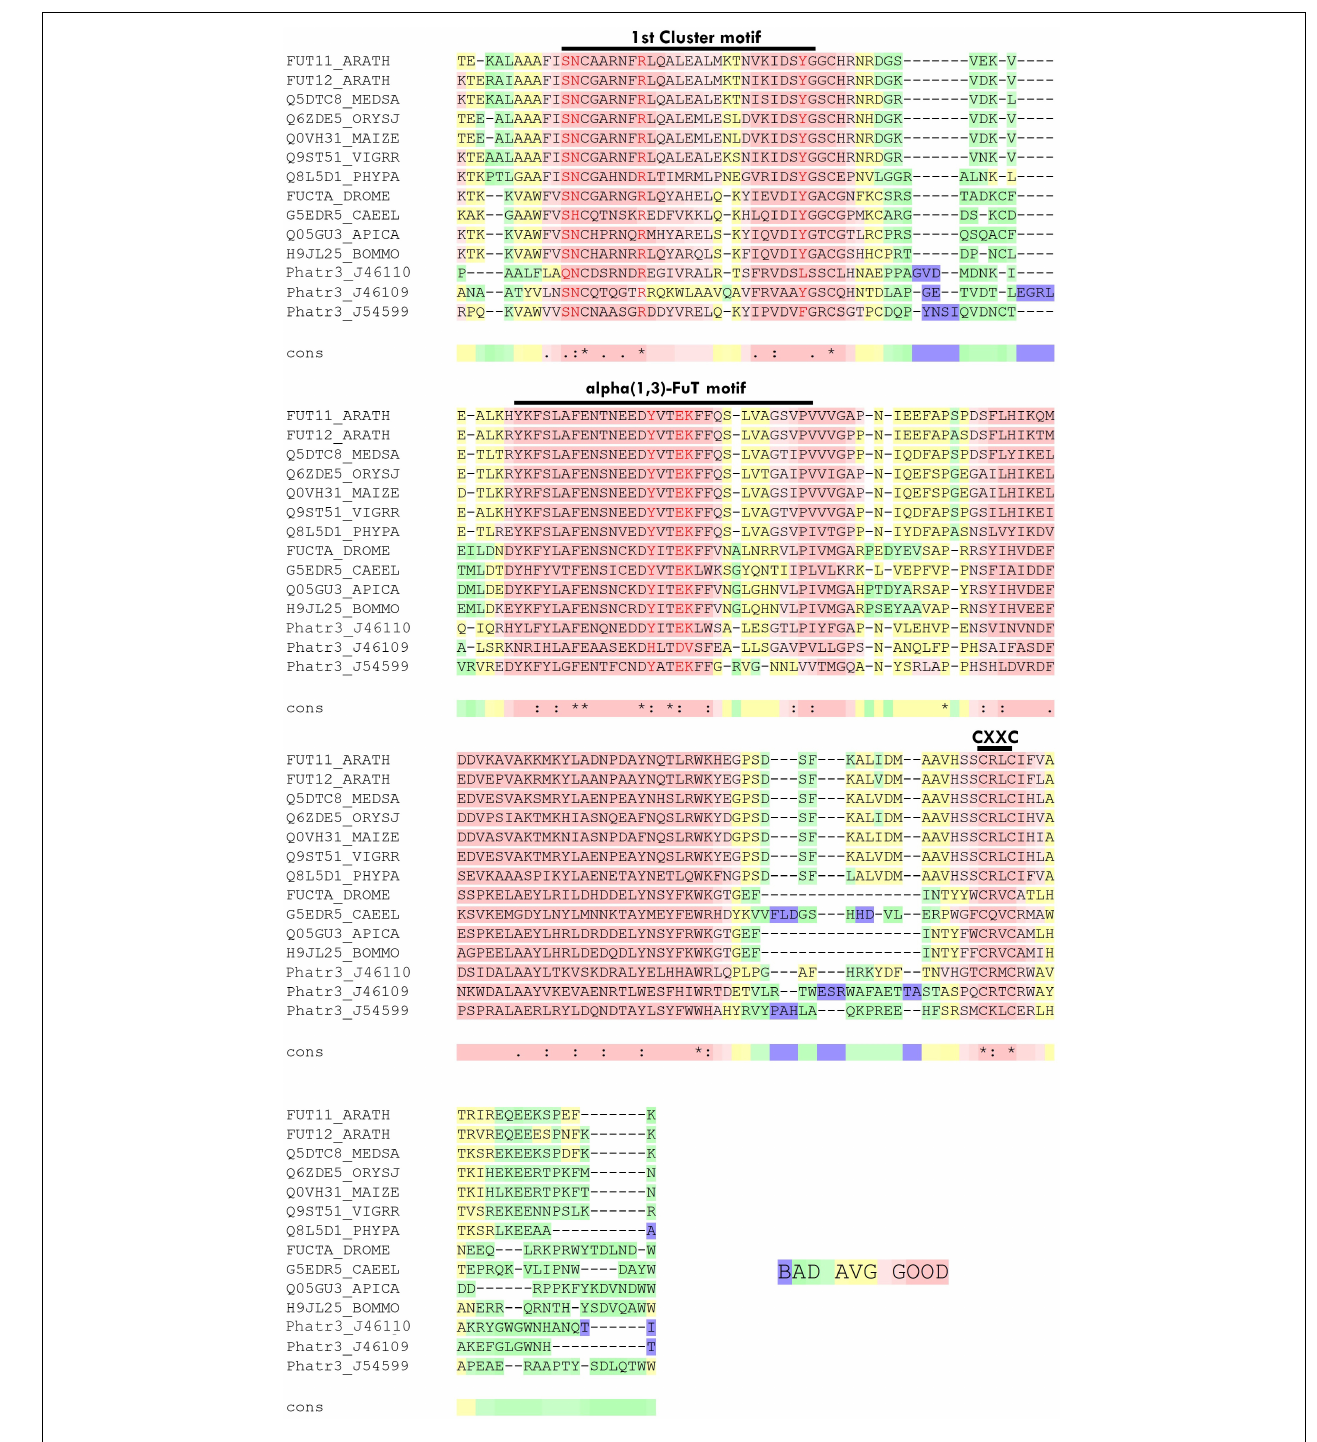
FIGURE 5 | Phaeodactylum tricornutum putative FuT exhibits strong amino acid identities with α (1,3)-fucosyltransferases. Amino acids sequences comparison with the T-coffee program (http://tcoffee.crg.cat/, Di Tommaso et al., 2011) of the C-terminal GT10 domains of the three putative fucosyltransferases encoded, respectively, by the Phatr3_J46109, Phatr3_J46110 and Phatr3_J54599 genes from Phaeodactylum tricornutum with biochemically characterized α (1,3)-fucosyltransferases from Arabidopsis thaliana (FUT11_ARATH and FUT12_ARATH), Medicago sativa (Q5DTC8_MEDSA), Oryza sativa (Q6ZDE5_ORYSJ), Zea mays Q0VH31_MAIZE), Vigna radiata (Q9ST51_VIGRR), Physcomitrella patens (Q8L5D1_PHYPA), Drosophila melanogaster (FUCTA_DROME), Caenorhabditis elegans (G5EDR5_CAEEL), Apis mellifera (Q05GU3_APICA) and Bombyx mori (H9JL25_BOMMO). The graphic output reflects the level of consistency of the alignment of a considered residue (from blue/green: badly or poorly supported to pink which corresponds to strongly supported). Conserved motifs of the GT10 domain are indicated on the top of the alignment.